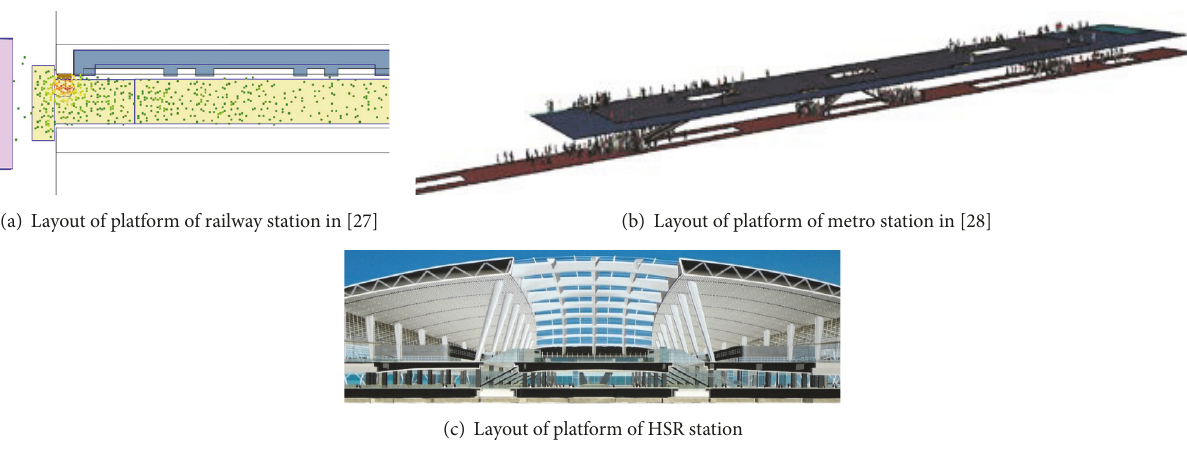
Figure 1: Architectural structure of platform of different stations.